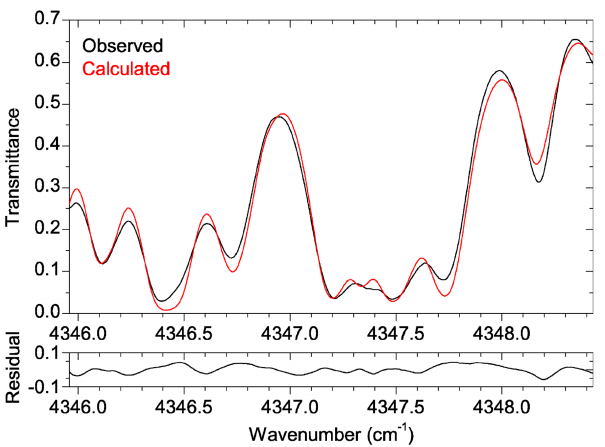
Fig. 1. Observed and calculated atmospheric transmittance spectra in the CH 4 region. All features arise from CH 4 . Published by Copernicus Publications on behalf of the European Geosciences